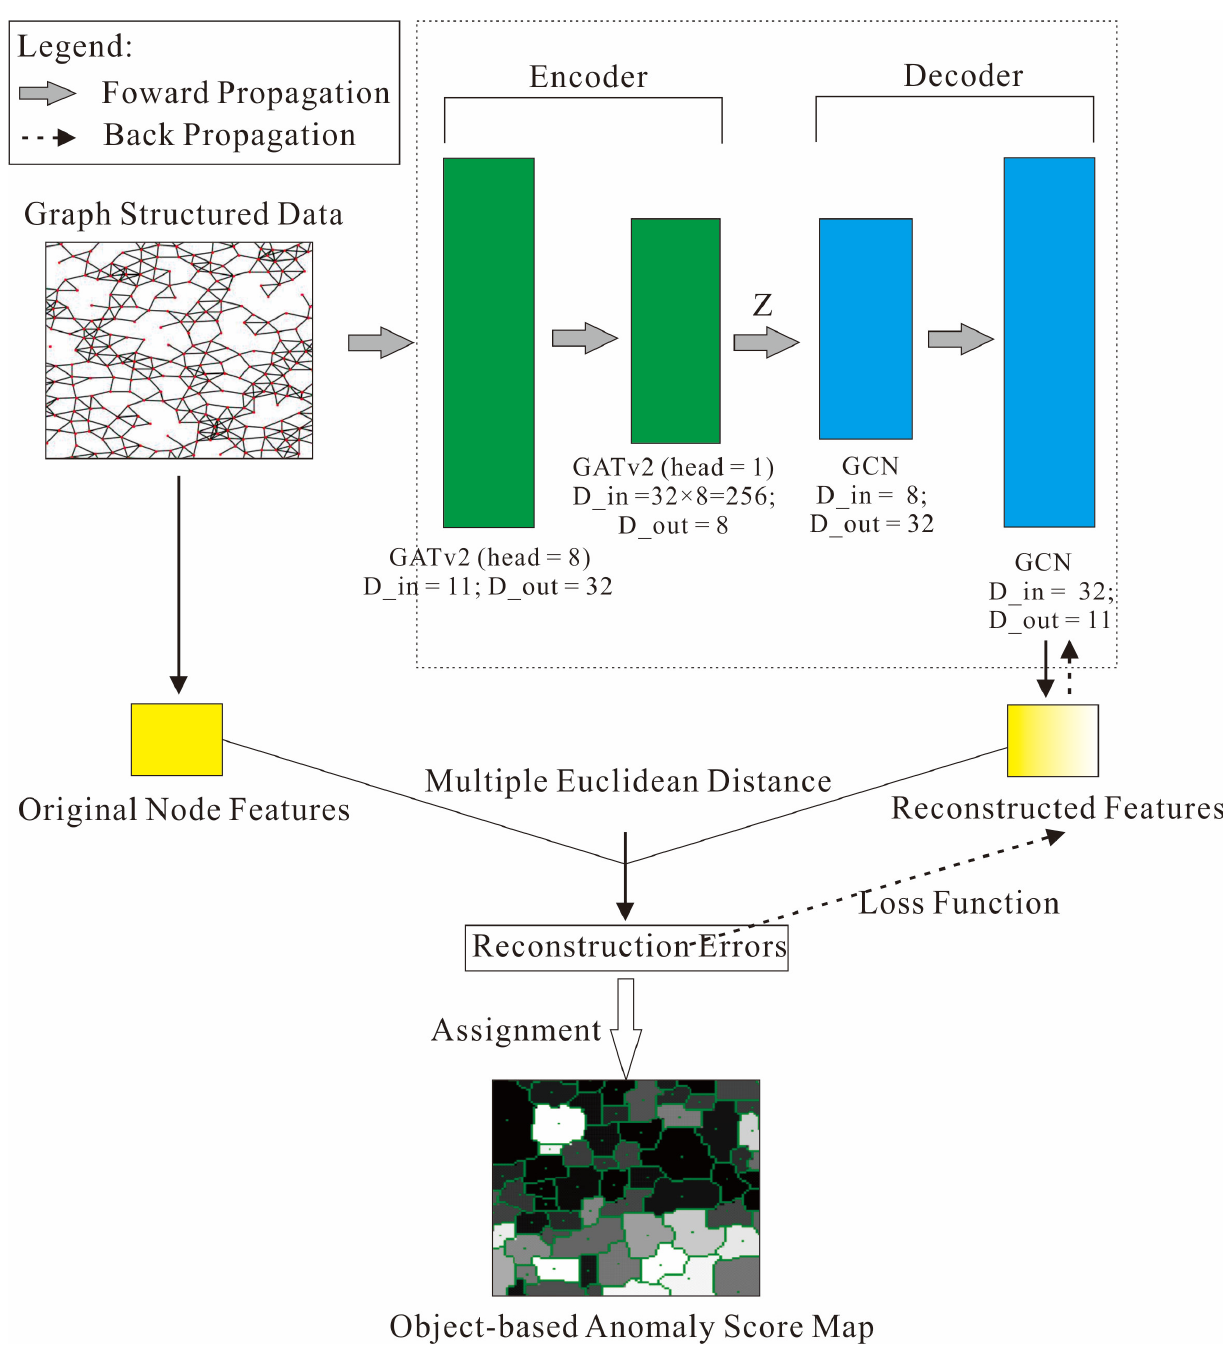
Figure 5. The overall OGE framework for geochemical anomaly identification. GATv2: Graph Attention Networks (Version 2); GCN: Graph Convolution Networks; D_in/D_out: Number of input/output channels.